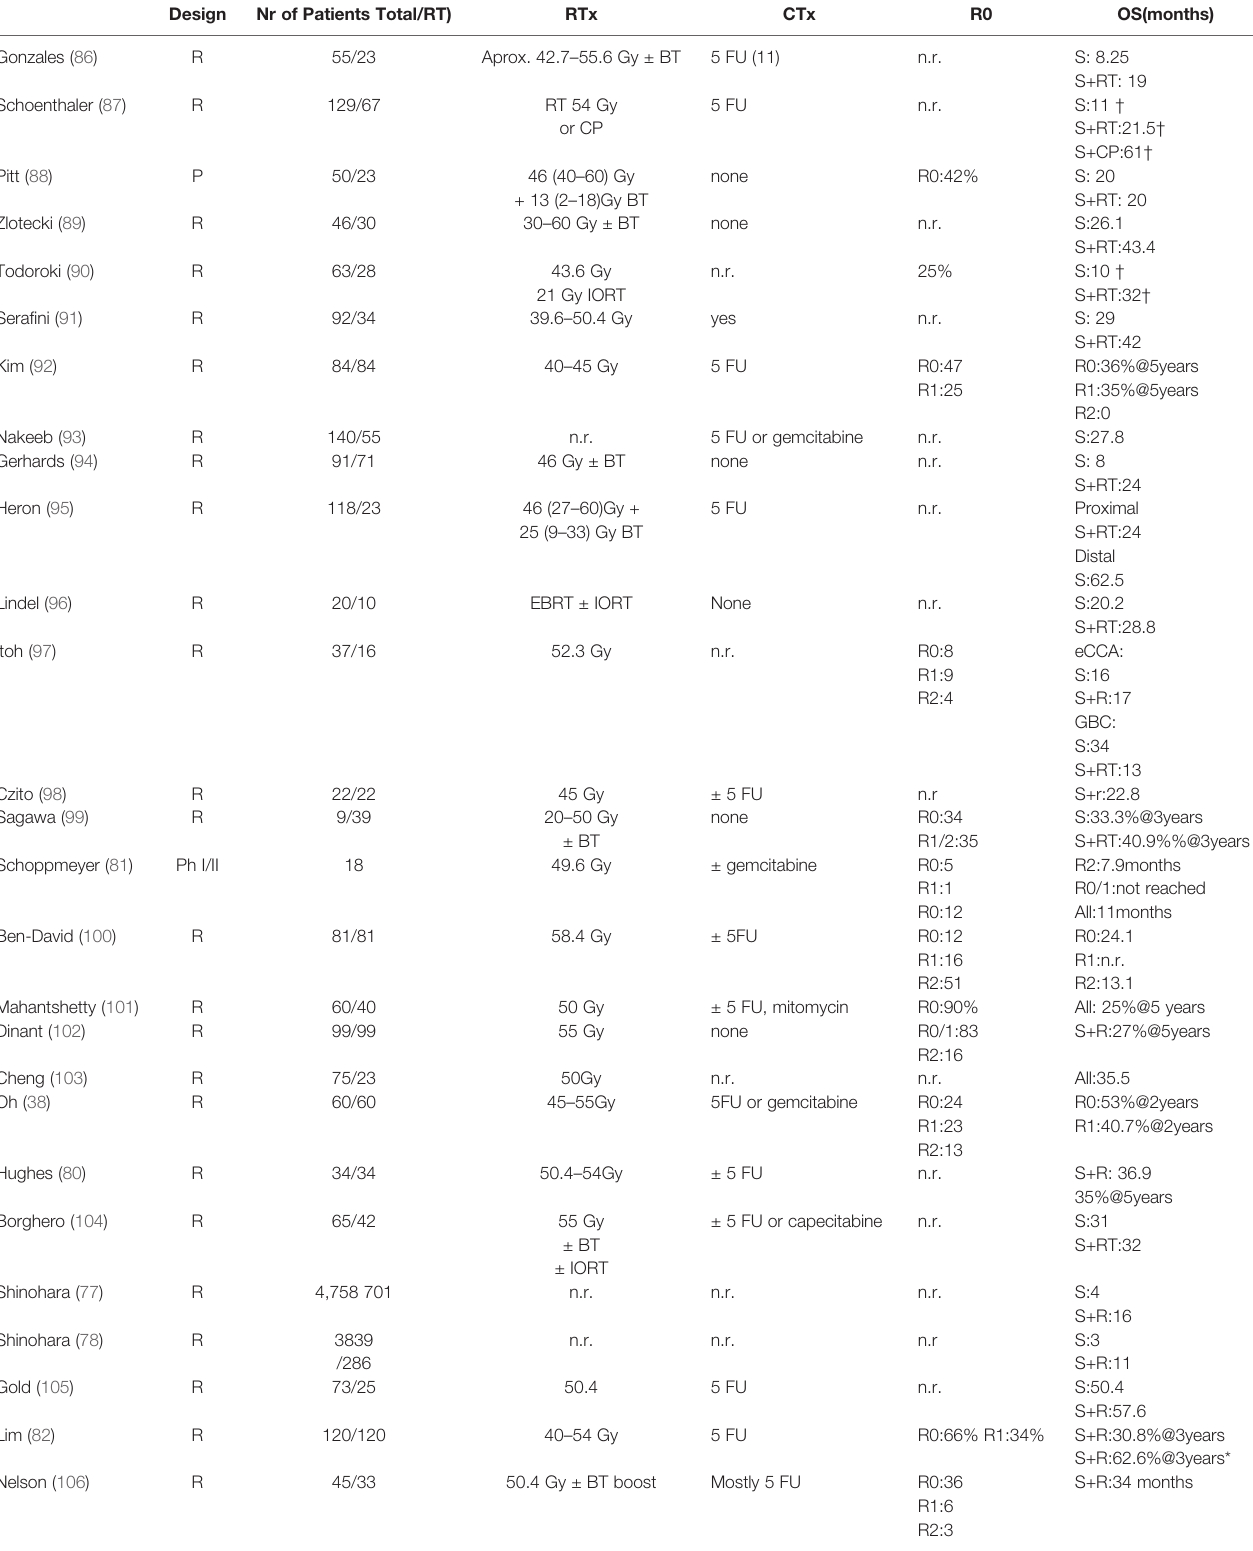
TABLE 2 | Selected results after adjuvant radio (chemo)therapy in cholangiocarcinoma.